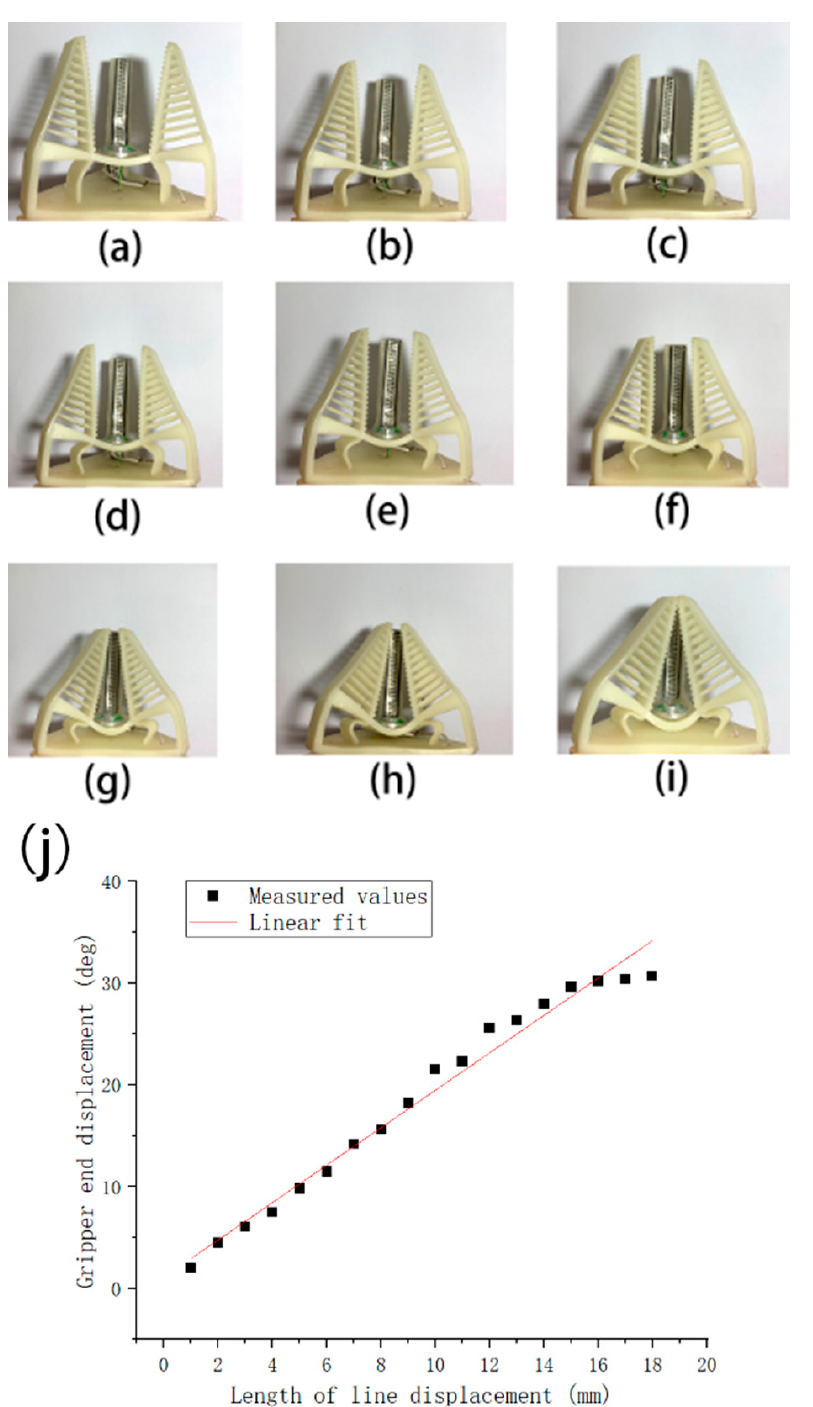
Figure 8. Changes in the state of the gripper during gripping with different degrees of deformation as shown in ( a – i ). The finger end angle change was measured once for every 1 mm change in the displacement of the pulling wire during the experiment, and a total of 18 numerical samples were taken. ( j ) shows the degree of deformation of the end of the finger in relation to the change in the displacement of the pulling wire.